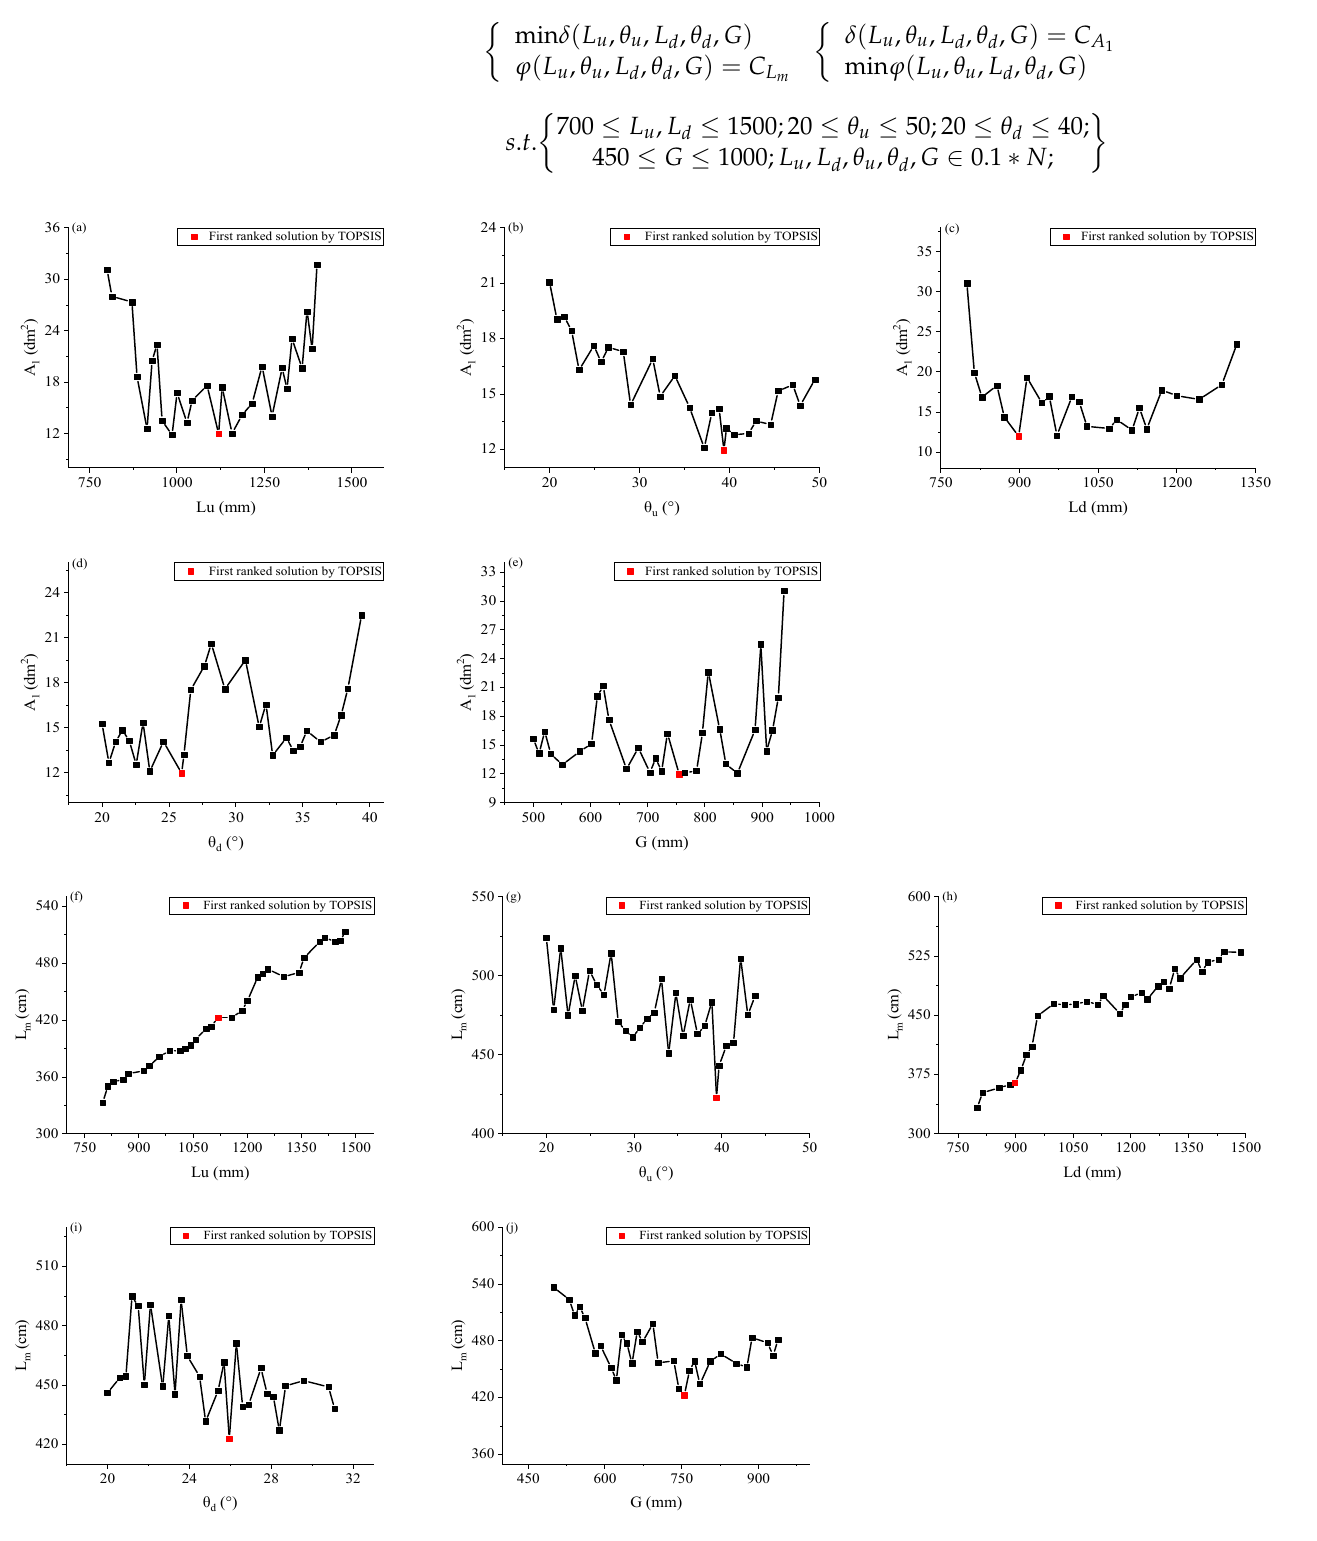
Figure 9. ( a – e ) The relationship between the structural parameters of the dual-manipulator and the optimization target A 1 . ( f – j ) The relationship between the structural parameters of the dual- manipulator and the optimization target L m